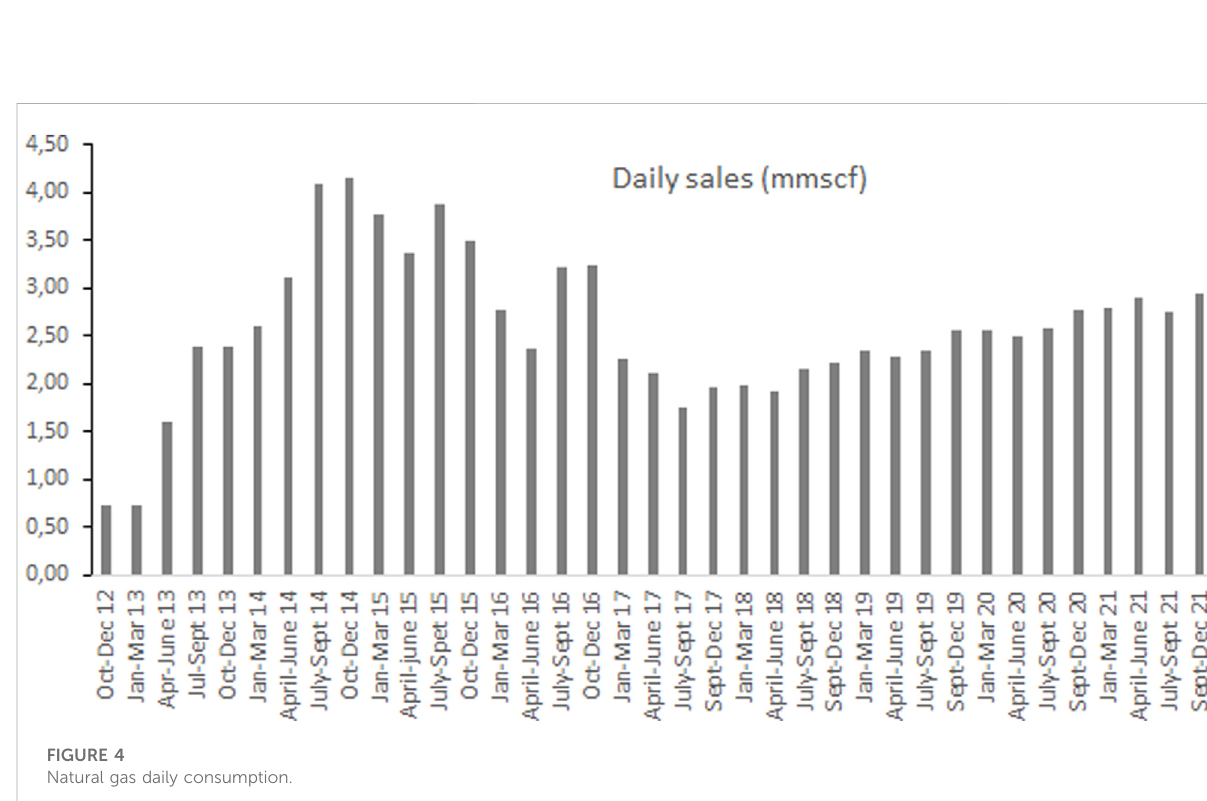
FIGURE 4 Natural gas daily